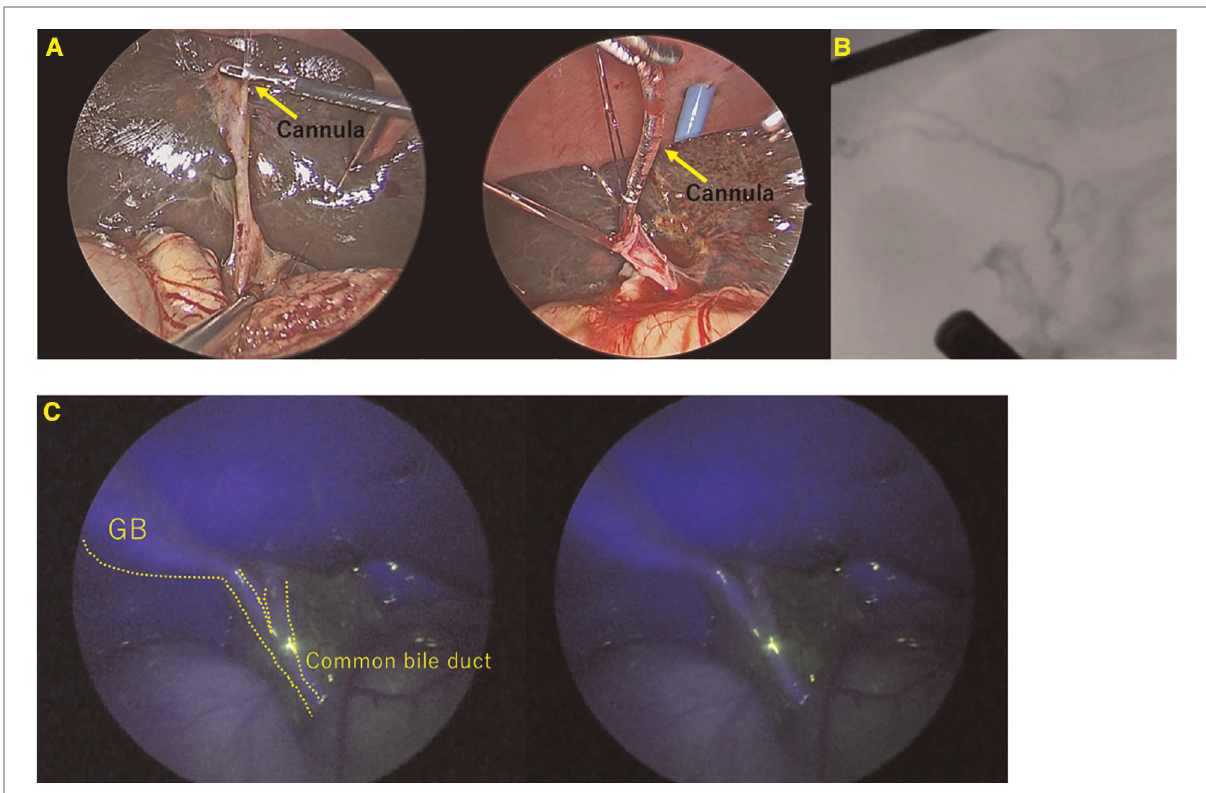
FIGURE 3 A case of Alagille syndrome requiring cholecystectomy after contrast due to dif fi culty in contrast from an atrophic gallbladder. ( A ) Cannulation into the gallbladder was dif fi cult and took many attempts. ( B ) Conventional cholangiography. ( C ) ICG Fluorescence